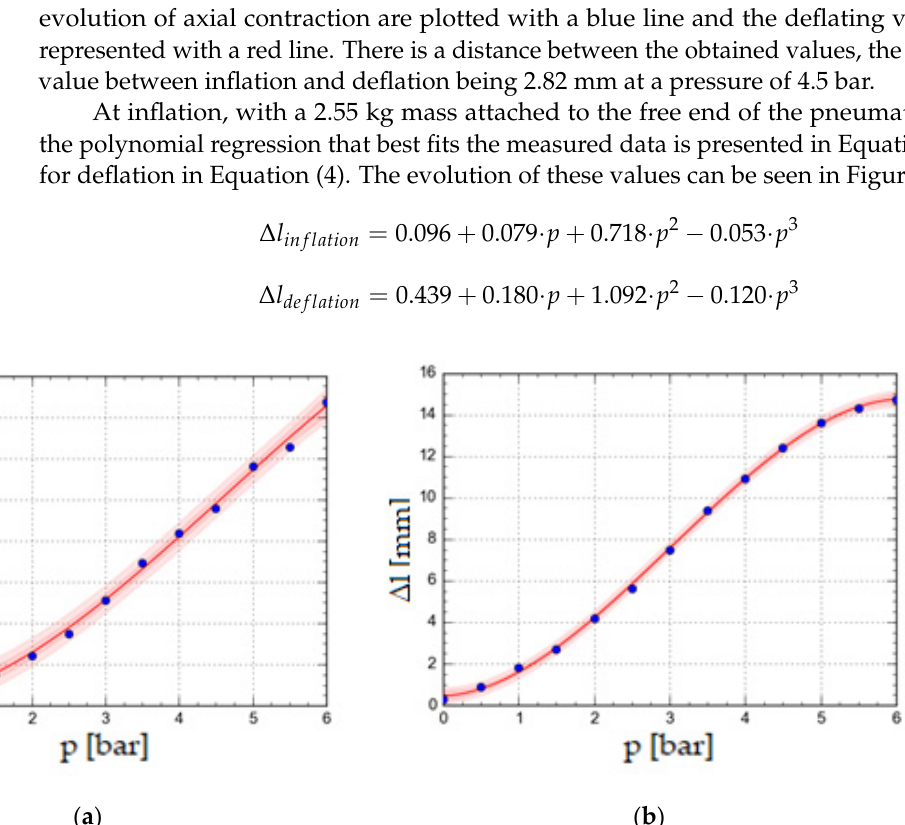
Figure 7. Evolution of axial contraction versus pressure (M = 2.55 kg).